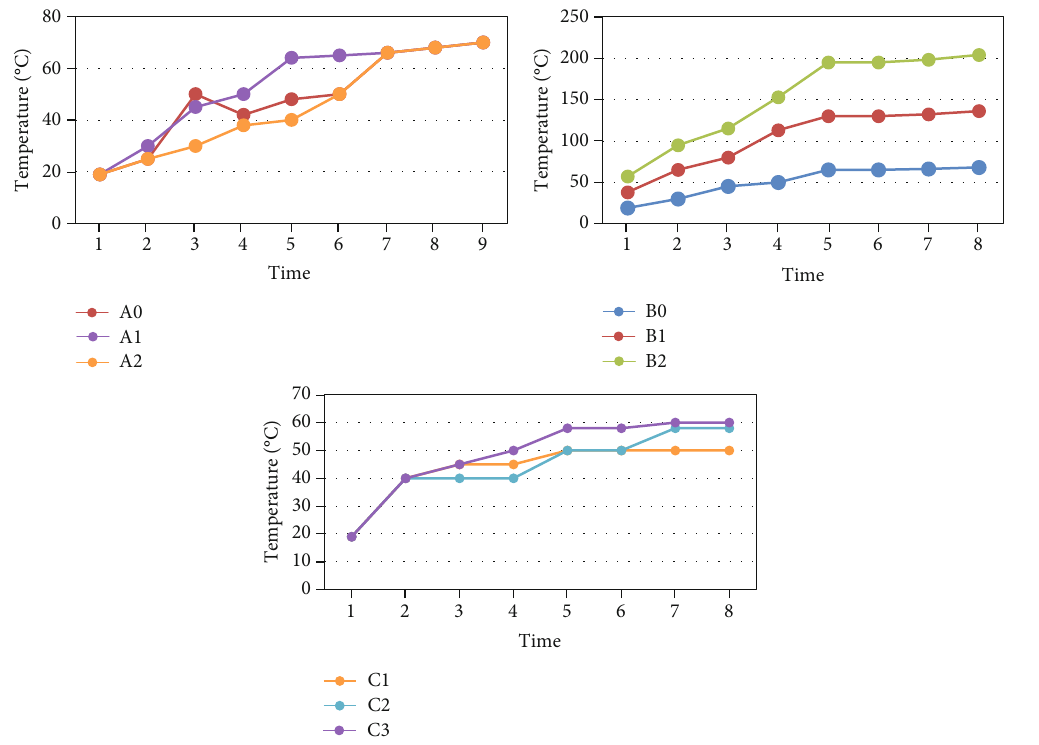
Figure 7: Temperature pro fi le of helical coil latent heat